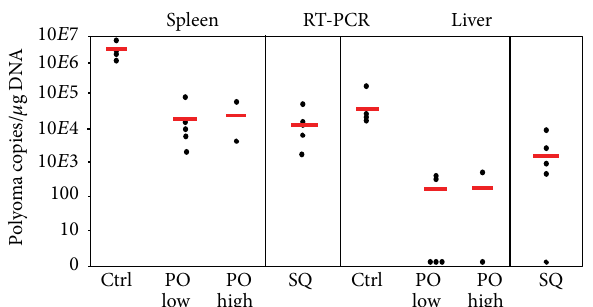
Figure 15: Viral load expressed as MPyV DNA genome levels in organs of YCP-VP1-GFP immunized and unimmunized (Ctrl) mice 5 days after MPyV infection. Mouse groups are as described in Figure 13. Red lines indicate the mean